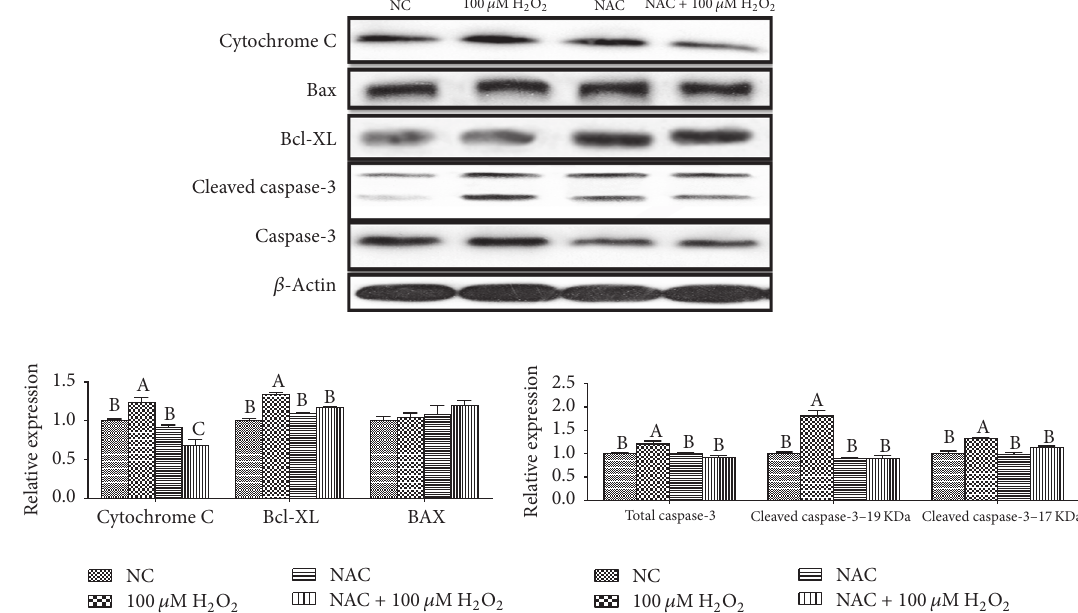
Figure 7: Abundances of proteins (cytochrome C, Bax, Bcl-XL, cleaved caspase-3, and caspase-3) in IPEC-J2 cells determined by western blot analysis. Cells were treated with 0 (NC) or 800 𝜇 M NAC and 0 or 100 𝜇 M H 2 O 2 , respectively. Data were expressed as means ± SEM of at least three independent experiments. a–c Values with different letters are significantly different ( 𝑃 < 0.05